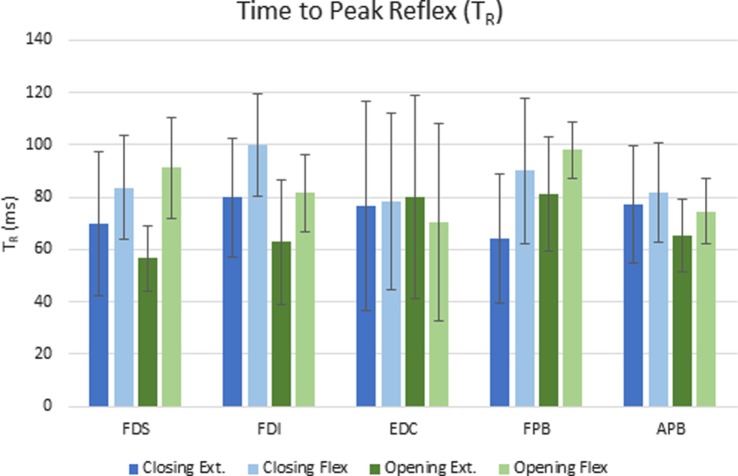
Mean elapsed time (ms) to peak reflex response (TR) for each condition across subjects. Error bars indicate ±1 SD.